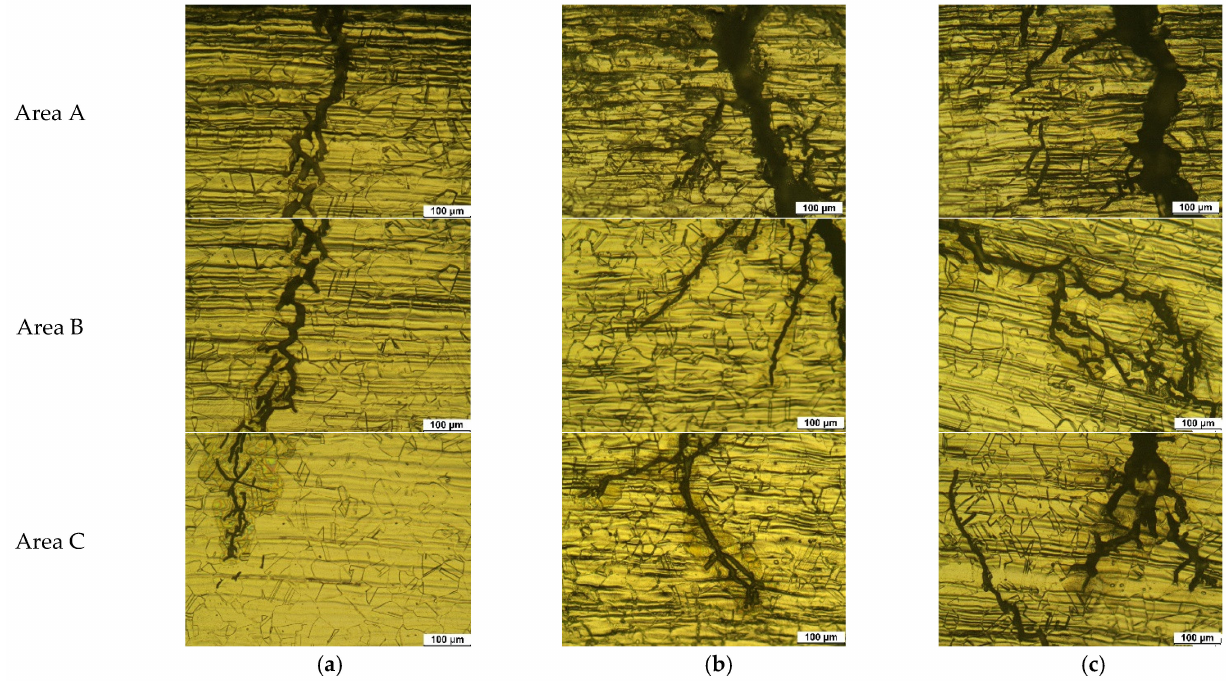
Figure 5. Crack morphologies of 304LB after U-bend SCC test (OM, × 200, 155 ◦ C, 42% MgCl 2 , Areas A, B, and C in Figure 5): ( a ) 304LB; ( b ) 304LB − L − NC; ( c ) 304LB − L −